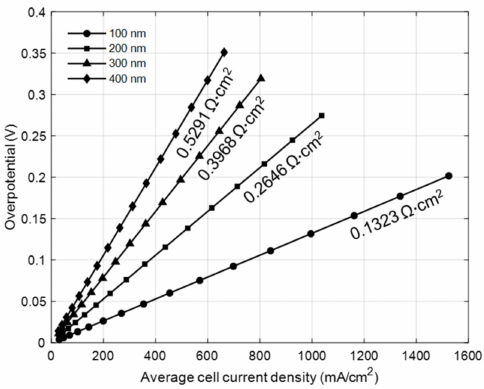
Figure 6. Ohmic overpotentials regarding the average cell current density with different electrolyte thickness at 400 ◦